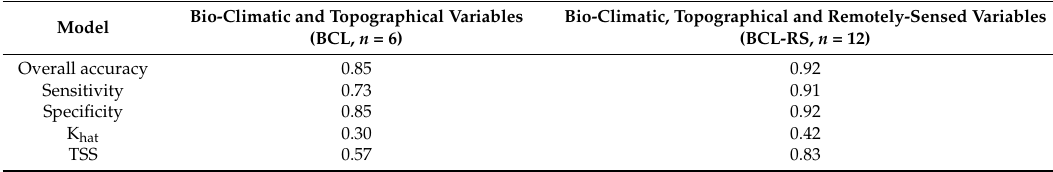
Table 2. Accuracy assessment statistics for the developed African citrus triozid ( Trioza erytreae ) MaxEnt models. Model